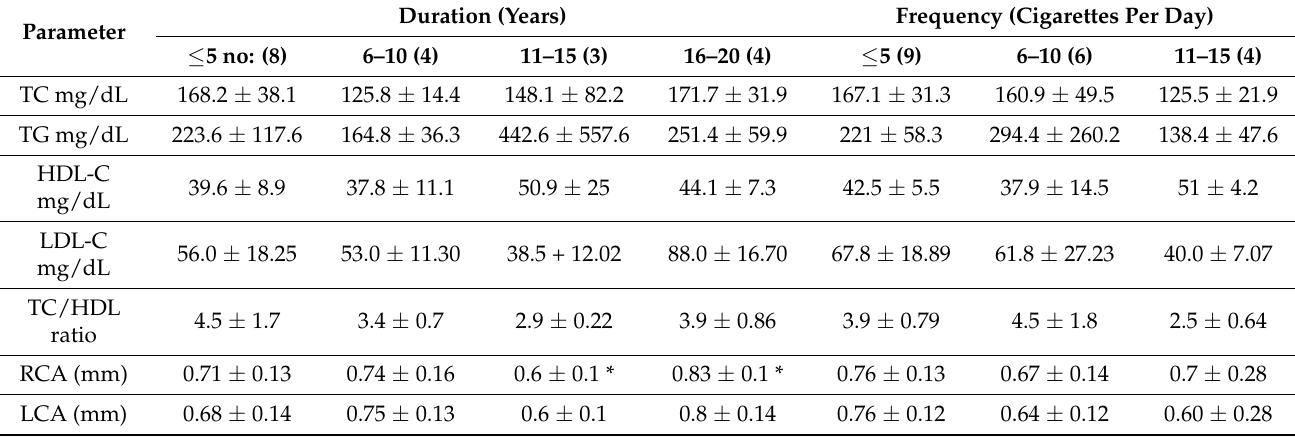
Table 3. The effect of the duration and frequency of smoking on the mean values of the studied parameters.